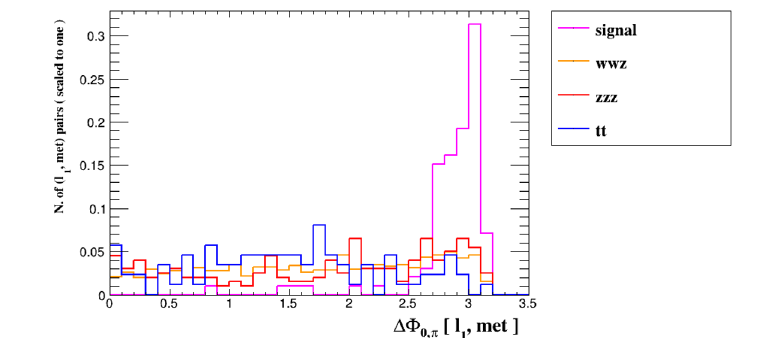
Figure 5 . The distribution of the azimuthal angle between the leading lepton and missing trans- verse energy, the different distributions are normalised to unity.